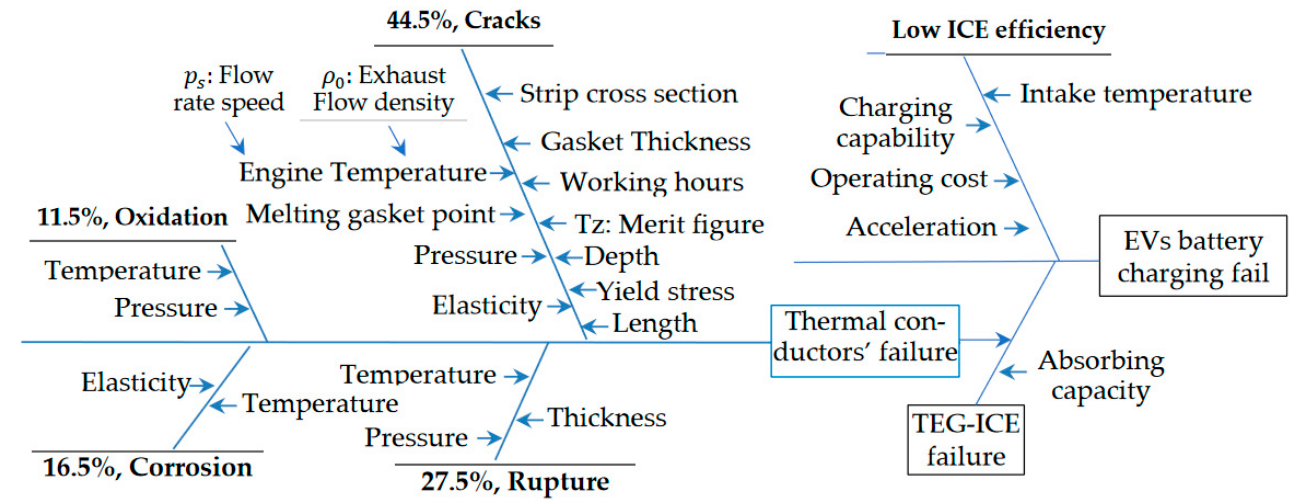
Figure 1. The cause and effect diagram for HVs charging failure due to heat conduction failure.